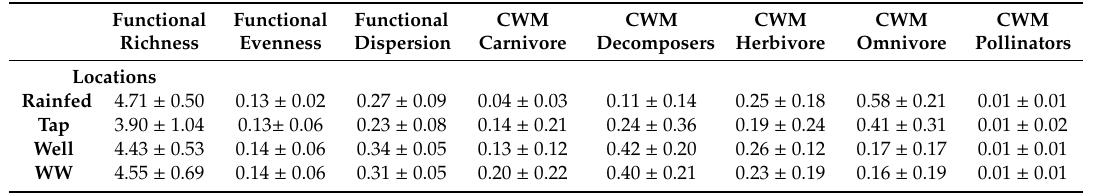
Table 4. Mean functional richness, evenness, and dispersion of arthropod communities as well as community-weighted mean ( ± standard deviation) of the five arthropod guilds recorded during a 72-h sampling, using the pan and pitfall traps in di ff erent vegetable fields in four UPA locations and with di ff erent irrigation water sources, namely, rainfed (RF), tap water (Tap), well water (Well), and wastewater (WW) in Tamale, Ghana in August 2016.